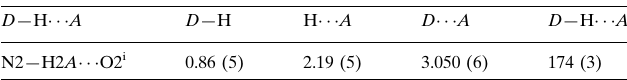
Hydrogen-bond geometry (A˚ , (cid:1)